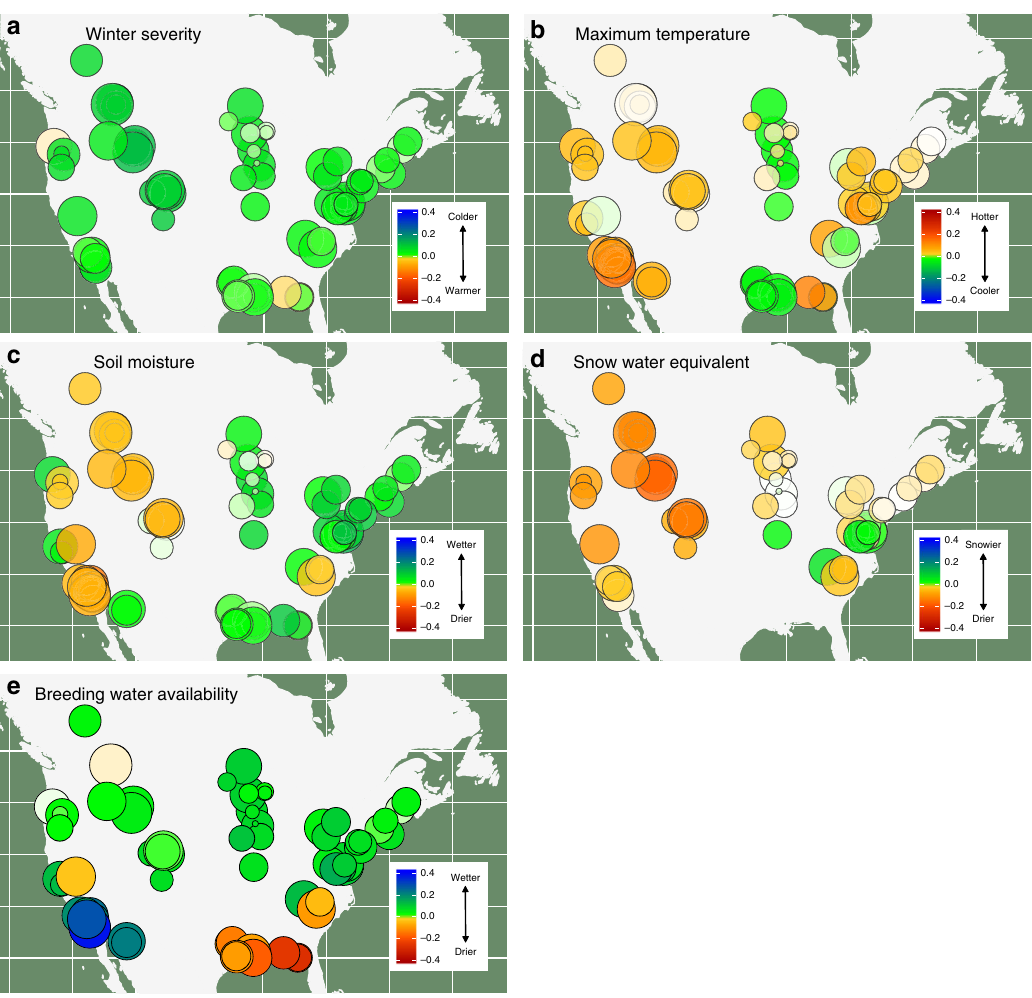
Fig. 5 Sensitivity to climate change across geographic space. We estimated how sensitive species richness was to changes in mean climatic conditions based on the estimated relationship between annual climate measures and colonization and persistence probabilities. Sensitivity is the expected rate of change in local species richness of individual sampling locations with respect to changes in the climatic variables. For example, a value of − 0.1 would indicate a one standard deviation increase in the climate variable would lead to a 10% loss in species richness. All climate variables are standardized based on observed variability over a 30-year period in the variable, allowing for direct comparison among climate variables. Positive values occur when we estimated a positive change in species richness (i.e., mean species occurrence probabilities for a location) as values of the climate variable increased (i.e., more severe [i.e., cold] winters ( a ), warmer extreme summer temperatures ( b ), greater snowfall ( c ), greater soil moisture ( d ), and more water during and immediately prior to breeding ( e )). Negative values represent a predicted decline in local species richness with a shift to higher values of the climate variable. Cool colors (greens and blues) denote that the species richness responds positively to either cooler or wetter conditions, depending on the climate variable. Warm colors (yellow, orange, red) denote that species richness responds positively to warmer or drier conditions for the climate variable. Circle sizes are proportional to the sample size for the study area (number of unique species, site, and year combinations). Missing values occur for snow water equivalent and winter severity for warmer areas where snowfall and days with mean temperature less than 0 were minimal. Maps used in this fi gure were generated using R package